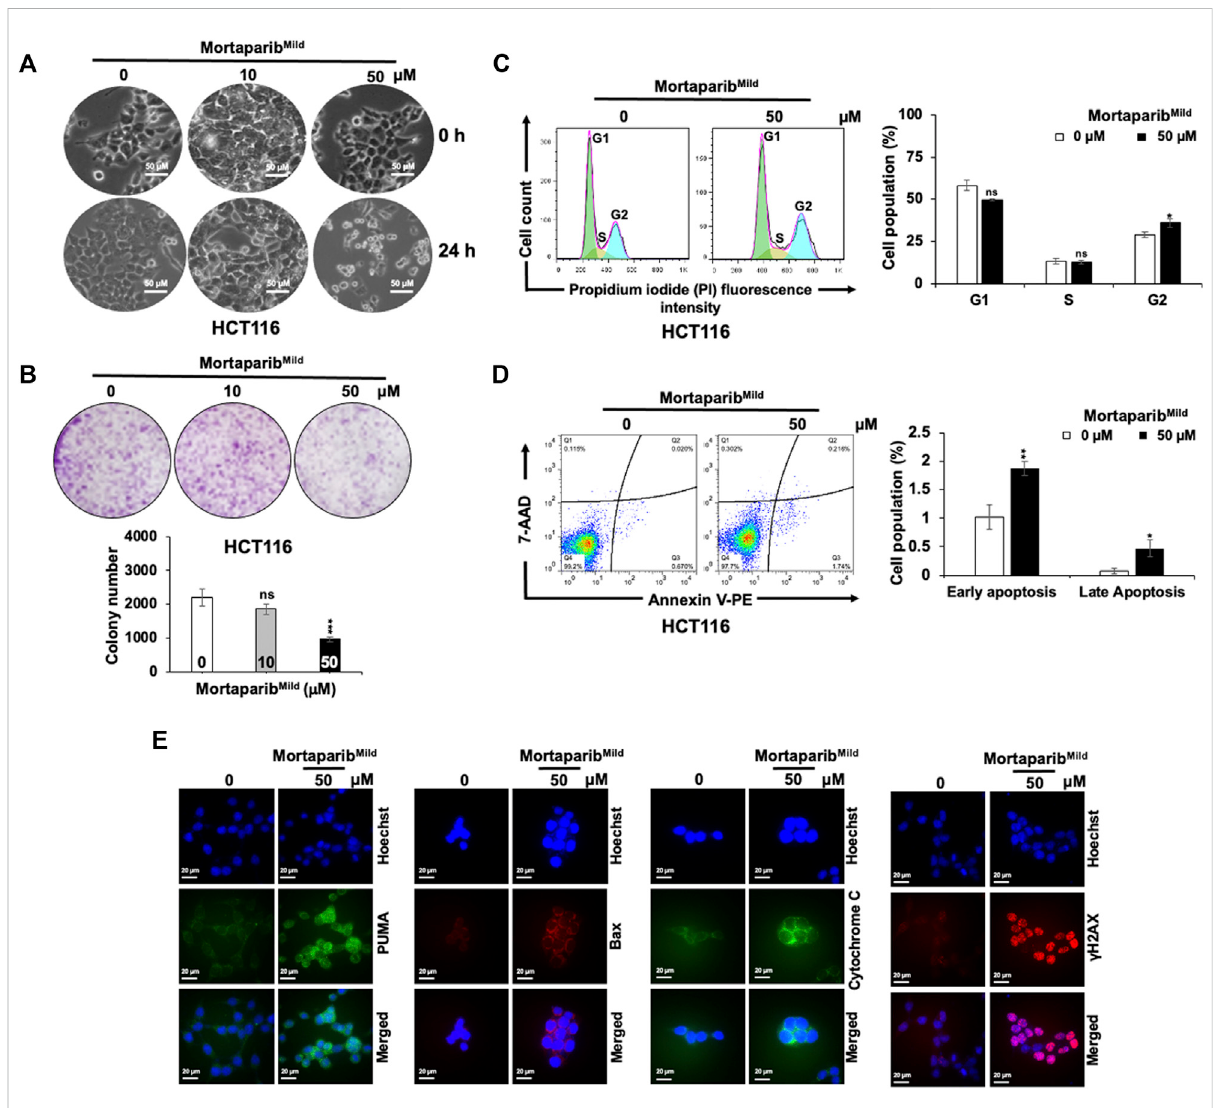
FIGURE 5 Mortaparib Mild causedinhibitionofcellproliferationinHCT116cells. (A) Cellmorphologyofthecontrolandtreated(10and50 μ M)cellsshowing growth arrest and apoptotic phenotypes post-24 htreatment is shown. (B) Colonyforming ef fi ciency in control and treated (10and 50 μ M; 10 days) showed dose-dependent decrease in colony forming ef fi ciency. Mortaparib Mild (50 μ M) induced G2/M cell-cycle arrest (C) and apoptosis (D) . The latter was validated by increase in expression levels of protein involved in apoptosis (PUMA, Bax and Cytochrome C) and DNA damage accumulation( γ H2AX). (E) .Eachdatasetrepresentedthemean±SDofatleastthreeindependentexperiments.Statisticalsigni fi cancewasde fi nedas values of p > 0.05 (ns), p ≤ 0.05 (*), p ≤ 0.01 (**), p ≤ 0.001 (***), and p ≤ 0.0001 (****), which represent non-signi fi cant, signi fi cant, very signi fi cant, highly signi fi cant, and extremely signi fi cant,